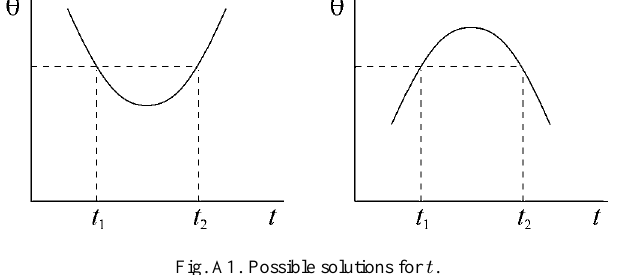
Fig. A1. Possible solutions for t